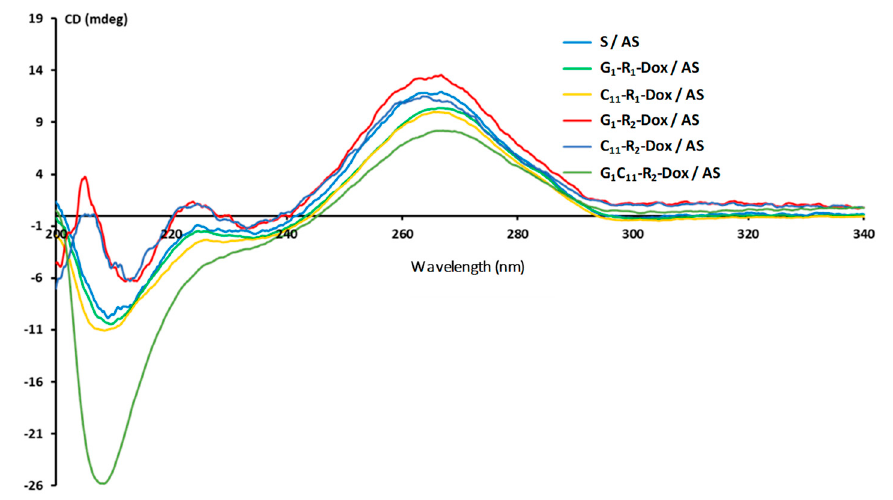
Figure 4. Circular dichroism (CD) spectroscopy curves of siRNAs duplexes formed between Dox-RNA conjugates with their complementary RNA AS strand (experiment performed at 41 °C).